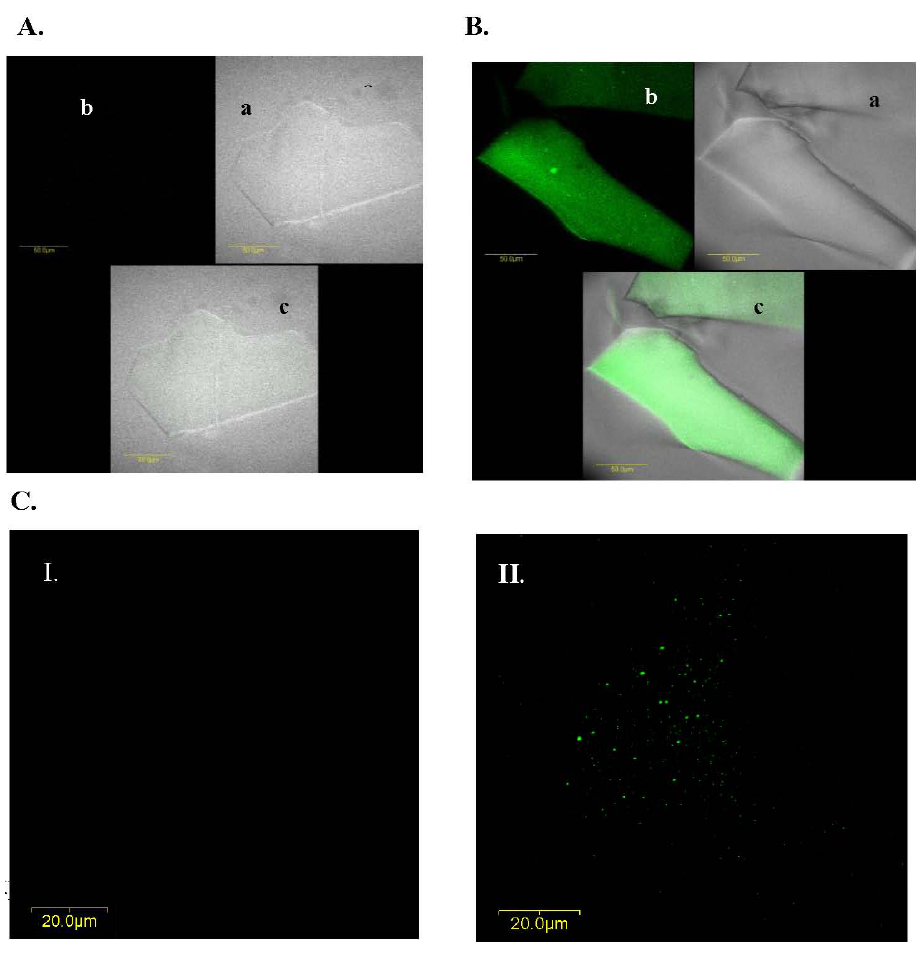
Figure 6. IgG distribution within a TMOS-based sol-gel prepared with a TMOS:HCl ratio of 1:8 containing 10% of 0.4-kDa PEG. A . Confocal microscopy image of ‘empty’ xerogel ( i.e ., sol-gel without IgGs). B . Images of xerogels containing FITC-labeled IgGs; xerogels were mounted on microscope slides and scanned with a fluorescent confocal microscope ( a ) phase image (without using laser beam at the tested wavelength); ( b ) fluorescence level of a doped sol-gel sample; and ( c ) superimposition of the phase and fluorescent images in (a) and (b). C . Confocal microscopy images of (I) empty, and (II) doped xerogels containing FITC-labeled IgGs and based on TMOS at a TMOS:HCl ration of 1:8 containing 10% of 0.4-kDa PEG. Images A and B were taken with a magnification of × 60; those in C were taken with a × 60 magnification and a × 2 zoom at a depth of 15 μ m. The scale bars in (A) and (B) represent 50 μ m; and in (C) represents 20 μ